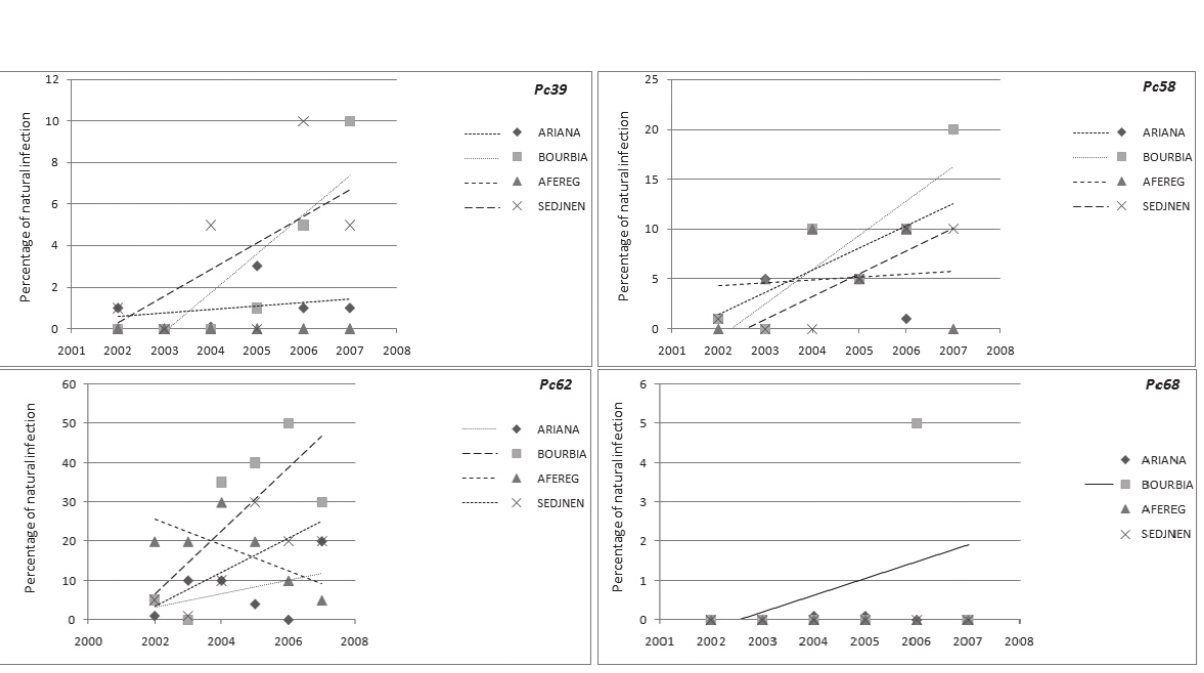
Figure 2. Regression of natural crown rust on the differential oat lines Pc39 , Pc58 , Pc62 and Pc68 during 2002 to 2007 in Ariana, Afereg, Bourbia and